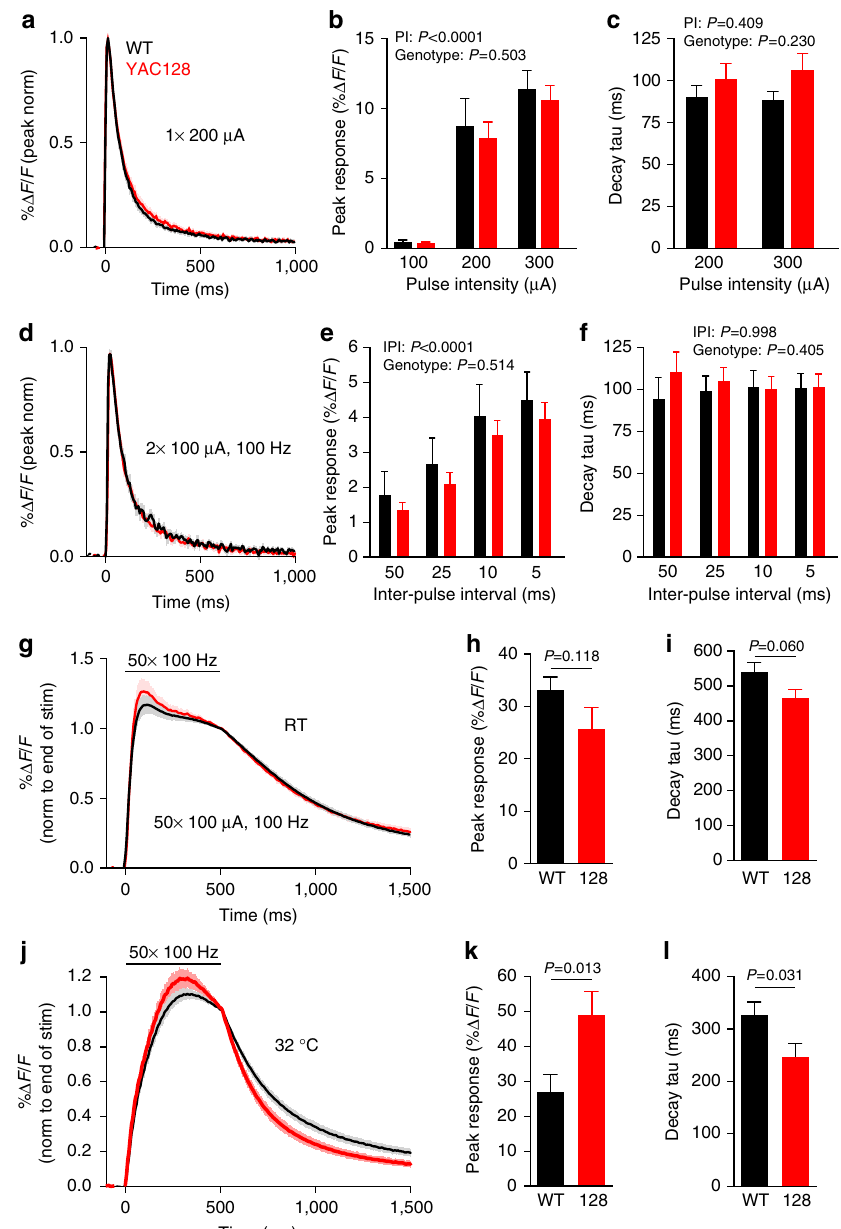
Figure 2 | Glutamate clearance in situ is not impaired in YAC128 dorsal striatum at 2 months of age. ( a ) Grouped data showing the average iGluSnFR response ( ± s.e.m.) to a single pulse (200 m A) in the dorsal striatum from both WT ( FVB/N ) and age-matched YAC128 mice. The responses are normalized (norm) to their peaks to simplify comparisons of decay kinetics. ( b , c ) Bar graphs showing iGluSnFR response amplitude ( b ; WT n ¼ 12, 9, 9 from left to right; YAC128 n ¼ 14, 12, 12 from left to right, two-way ANOVA) and decay time ( c ; WT n ¼ 9 per bar; YAC128 n ¼ 12 per bar, RM two-way ANOVA) evoked by single pulses at increasing intensities. Response size but not decay is dependent on the pulse intensity (PI). No genotype differences are seen in either peak or decay. The responses were barely detectable following a single pulse at 100 m A and therefore no decay tau was calculated for this condition. ( d ) Average-normalized iGluSnFR response to a paired-pulse stimulation in the dorsal striatum from both WT ( FVB/N ) and age-matched YAC128 mice. ( e , f ) Bar graphs showing iGluSnFR response amplitude ( e ) and decay time ( f ) in response to paired pulses at decreasing inter-pulse intervals (IPI; WT n ¼ 12 per bar; YAC128 n ¼ 14 per bar). The response size but not decay is dependent on IPI (RM two-way ANOVA). No genotype differences are seen in either peak or decay (RM two-way ANOVA). ( g ) Average iGluSnFR response at room temperature (RT) to a high-frequency stimulation (HFS) consisting of 50 pulses over 500ms. The responses are normalized to their value at the end of stimulation to simplify comparisons of the decay time course. ( h , i ) Bar graphs demonstrating no significant differences between WT ( n ¼ 21) and YAC128 ( n ¼ 17) for iGluSnFR amplitude ( h ) and decay ( i ) following HFS at RT. ( j – l ) Same as g – i , except that experiments were performed at 32 (cid:2) C. Under these conditions, iGluSnFR responses from YAC128 striatum ( n ¼ 11) were significantly larger ( k ) and decayed faster ( l ) in comparison with WT ( n ¼ 13). An unpaired t -test was used for h , i , k and l